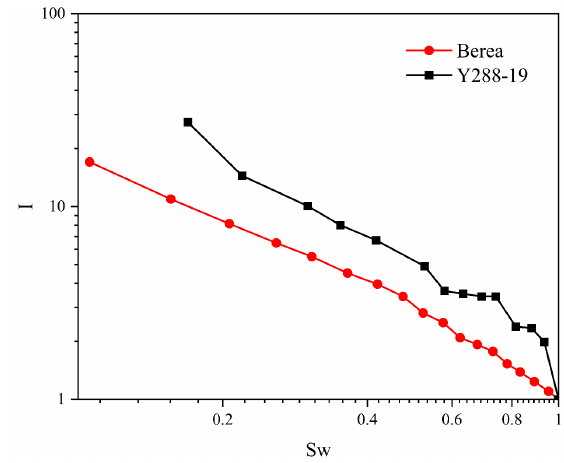
Figure 14. I-Sw curves of the two types of cores.